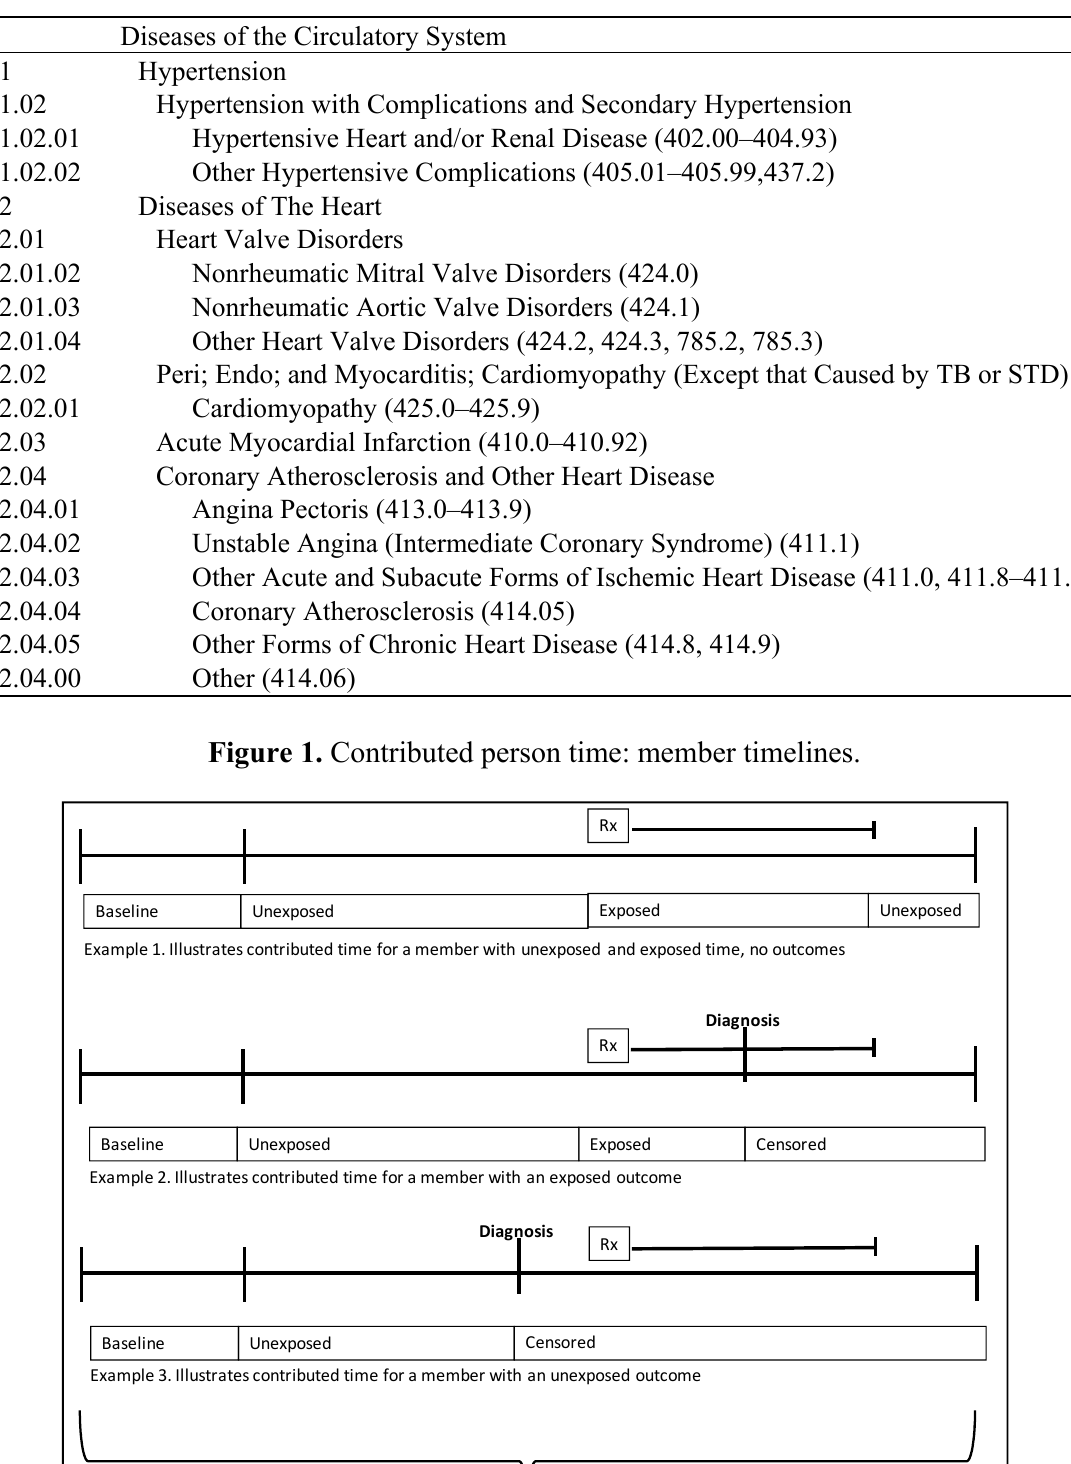
Table 1. A small subset of the Multi-Level Clinical Classification Tree with International Classification of Diseases, Ninth Revision (ICD-9) codes associated with a specific level.